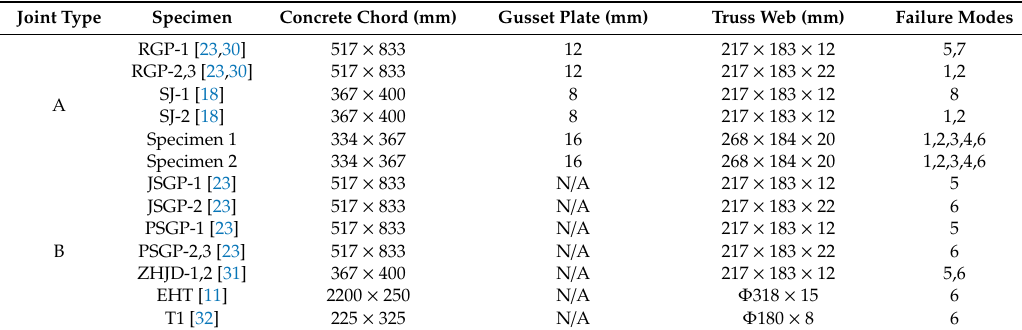
Table 2. Comparison of the failure